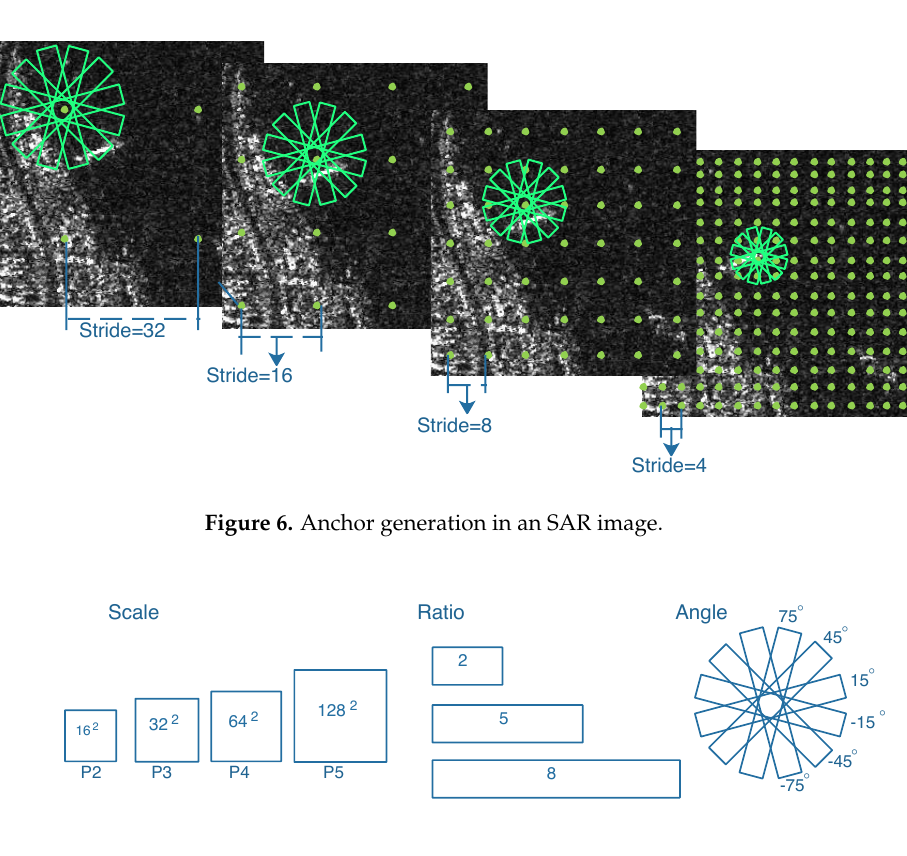
Figure 7. Cell anchor